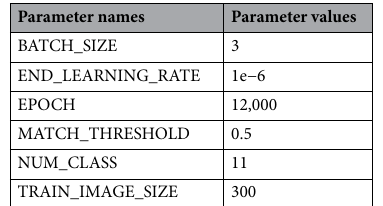
Table 5. Partial experimental parameters of SSD.